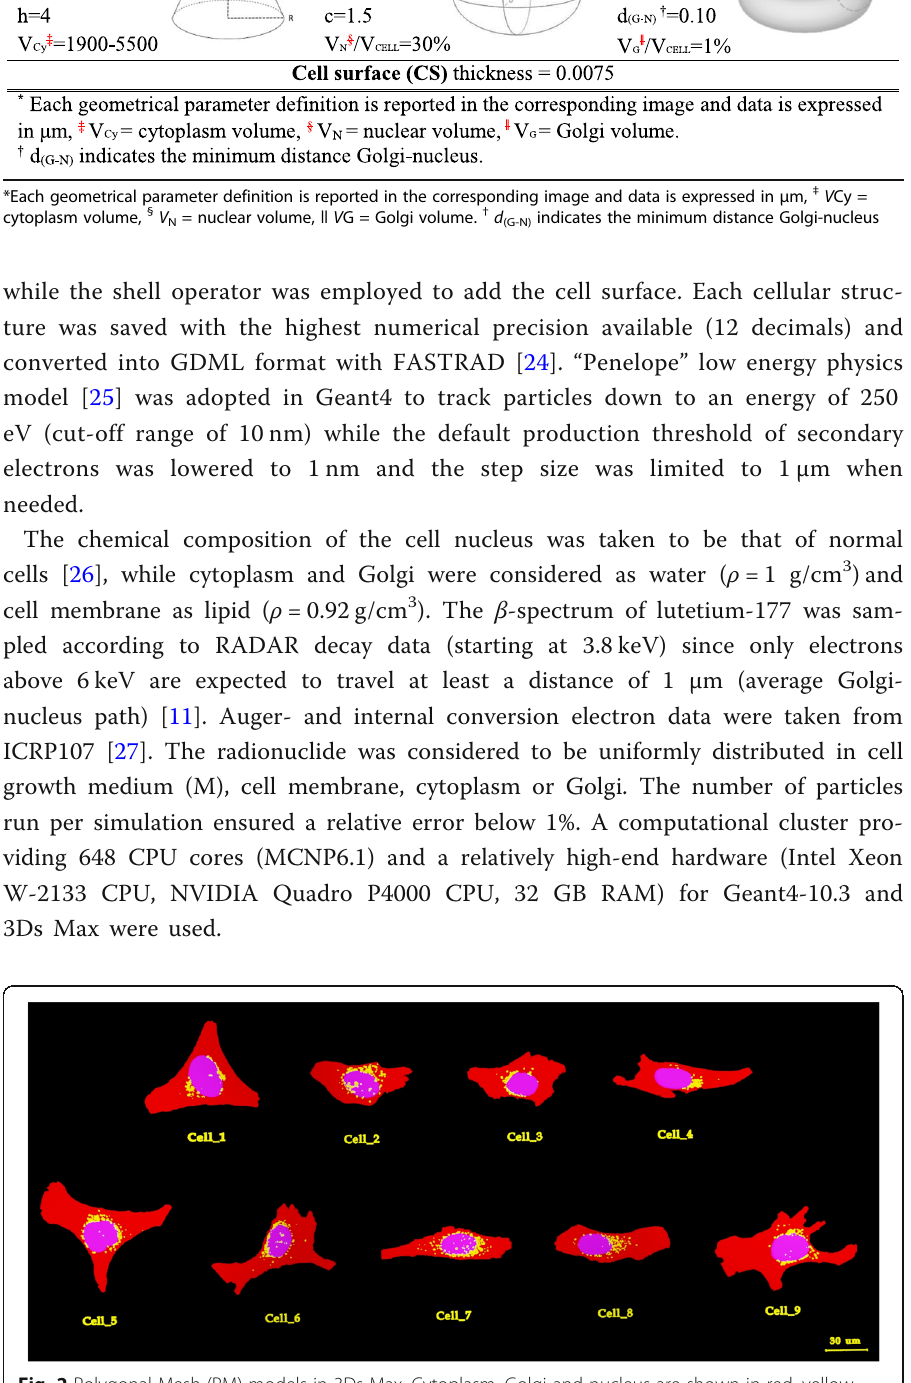
Fig. 2 Polygonal Mesh (PM) models in 3Ds Max. Cytoplasm, Golgi and nucleus are shown in red, yellow and blue, respectively. The scale bar is 30 μ